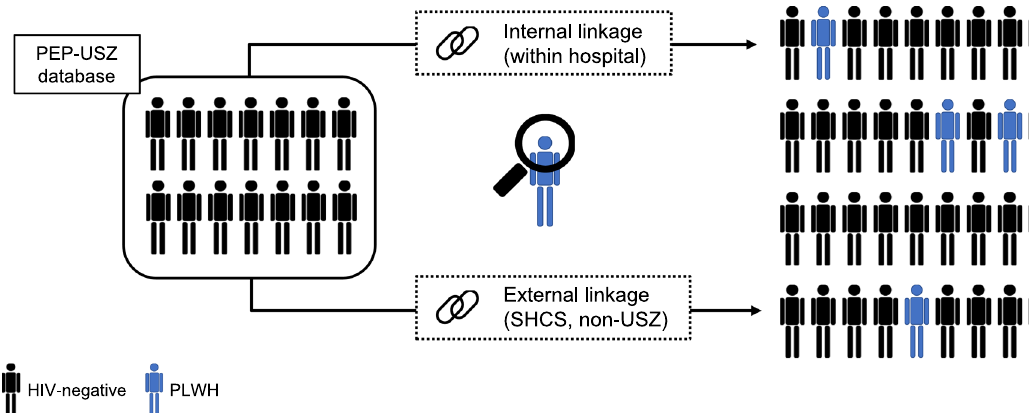
Fig. 4 Study design. Records retrieved from the PEP-USZ database were linked with 2 cohort studies, using a common unique identi fi er (internal linkage: ZPHI and USZ-speci fi c part of SHCS) or a privacy preserving probabilistic linkage (external linkage: SHCS, non-USZ part), with the aim to identify PLWH (blue person). PEP: post-exposure prophylaxis; PLWH: person living with HIV; SHCS: Swiss HIV Cohort Study; USZ: University Hospital of Zurich; ZPHI: Zurich Primary HIV Infection